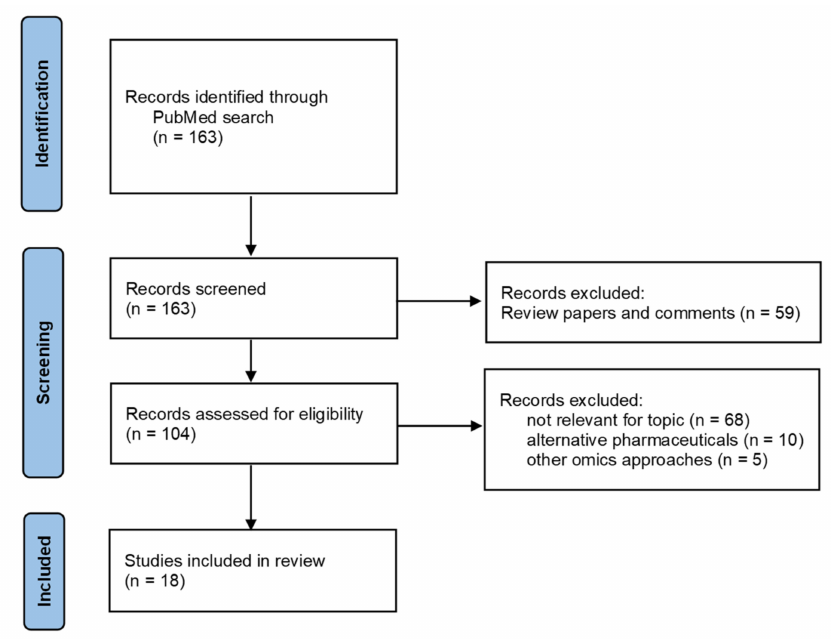
Figure 2. Flow diagram of literature search (time frame: 2010–2021; database: